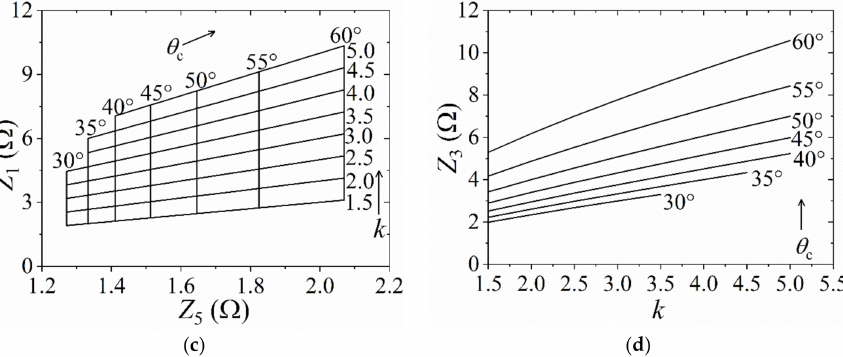
Figure 9. Relationships among characteristic impedance, k and θ c of case 21 under the condition of RL = 20 dB. ( a ) Relationships about Z ev 2 and Z ev 4 . ( b ) Relationships about Z od 2 and Z od 4 . ( c ) Rela- tionships about Z 1 and Z 5 . ( d ) Relationships about Z 3 and k .